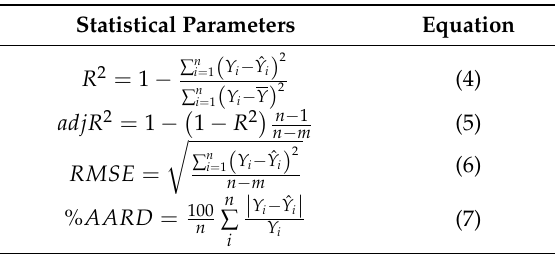
Table 3. Equations of statistical parameters